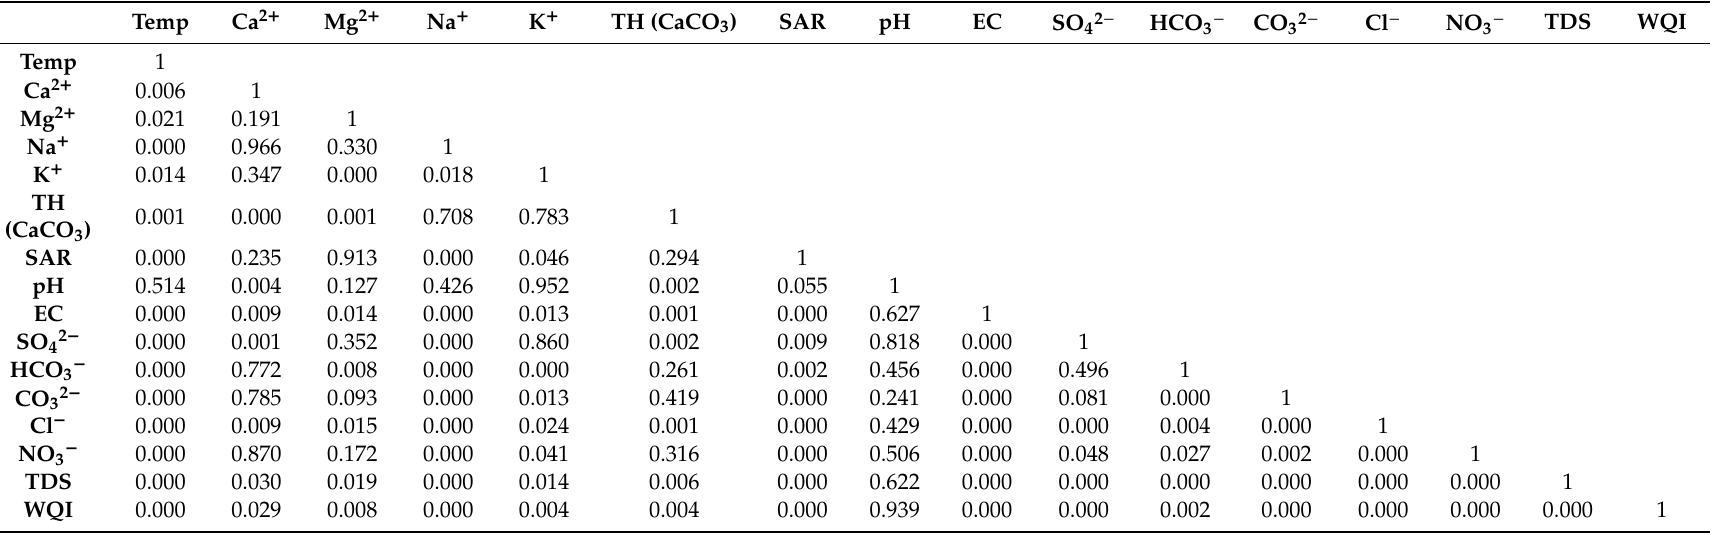
Table 4. Spearman´s rank correlation matrix, illustrating the relationship between the 16 variables determined in groundwater and surface